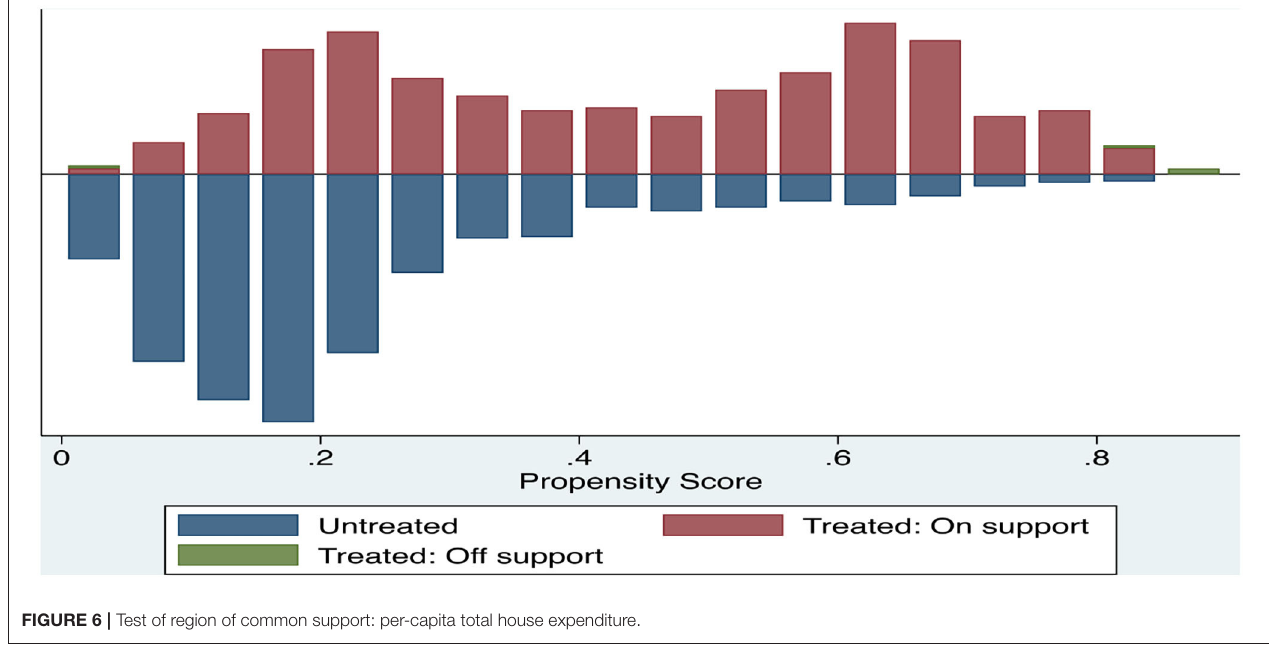
FIGURE 6 | Test of region of common support: per-capita total house expenditure.